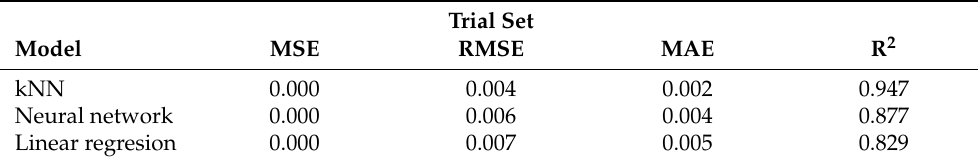
Table 2. Performance results of using the various algorithms to predict the permeability coefficient.